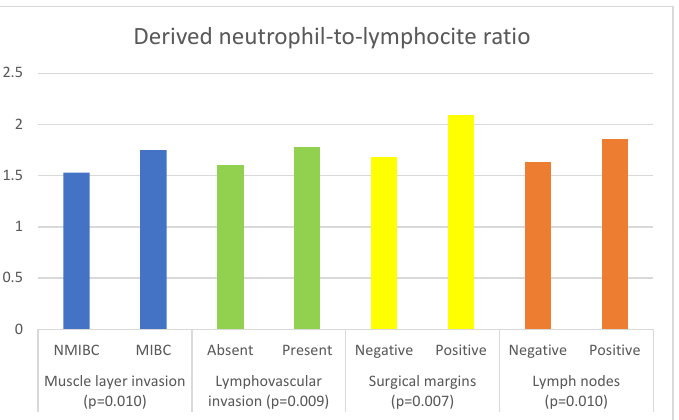
Figure 2. Significant associations of derived neutrophil-to-lymphocyte ratio with histopathological characteristics of bladder cancer.